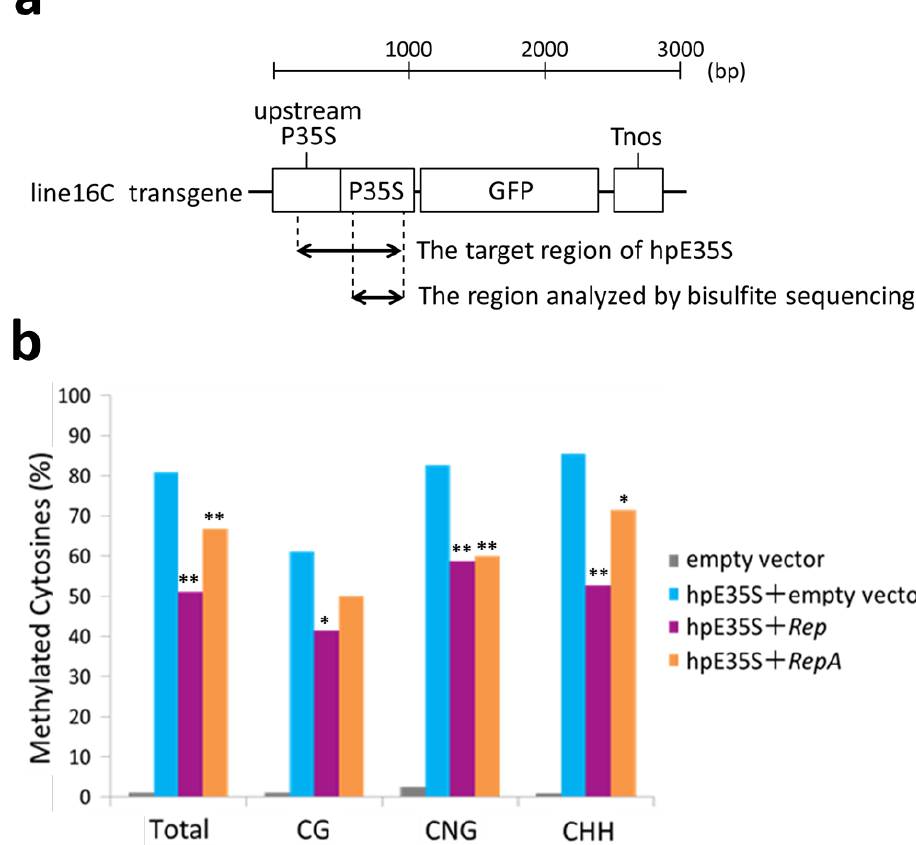
Figure 3. Cytosine methylation profiles in the enhancer region of 35S promoter from line 16C plants inoculated with empty vector, hpE35S + empty vector, hpE35S + Rep , or hpE35S + RepA at 5 dpi. ( a ) Schematic diagram of Nicotiana benthamiana line 16C transgene. The enhancer region corresponding to hpE35S and the region analyzed by bisulfite sequencing are indicated. P35S; Cauliflower mosaic virus (CaMV) 35S promoter, Tnos; nos terminator. ( b ) Percentage of methylated cytosine in different sequence contexts. Student ′ s t -test was performed using the methylation values from individual clones. Single and double asterisks indicate significant differences in methylation sites at p < 0.05 and p < 0.01, respectively, between hpE35S + empty vector and hpE35S + Rep or hpE35S + Rep